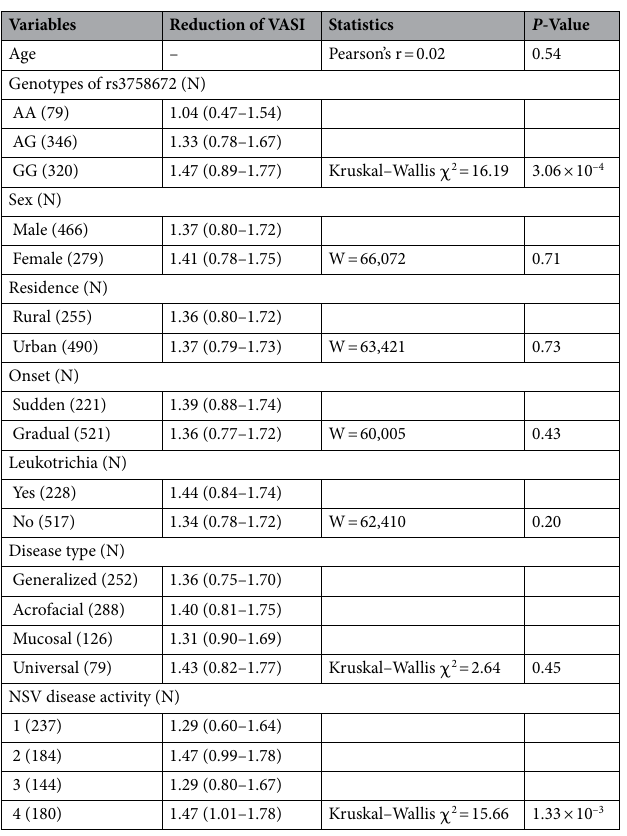
Table 3. Relationship between reduction of VASI and baseline variables in patients of the validation set. VASI: Vitiligo Area Severity Index. Continuous variables were presented by median value with interquartile range. The P values for Hardy–Weinberg equilibrium tests of rs3758672 in the validation set were 0.33 and 0.57 for cases and controls, respectively.